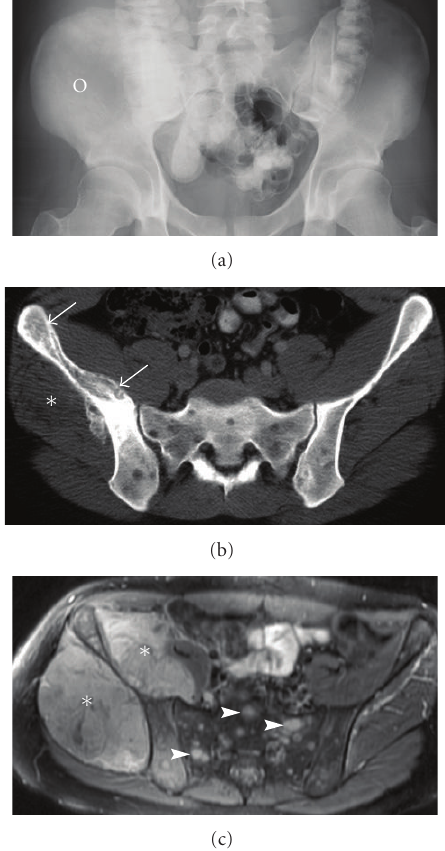
Figure 3: Ewing’s sarcoma. A 21-year-old male with advanced Ewing’s sarcoma. AP radiograph (a) of the pelvis reveals a vague mixed density abnormality di ff usely involving the right ilium (circle). Note the asymmetry when compared to the normal left ilium. Incidental note is made of oral contrast in the bowel. CT scan (b) of the pelvis demonstrates permeative lesion of the right ilium (arrows) and an associated soft tissue mass (asterisk). Small multifocal lytic lesions in the sacrum and bilateral ilium are in keeping with metastasis. Axial T2 image (c) of the pelvis reveals a large exophytic soft tissue mass (asterisk) along the anterior and posterior borders of ilium. Note the predominance of a huge soft tissue mass when compared to the bone abnormality, characteristic of small round blue cell tumors. Marrow edema is noted in the a ff ected right ilium and multiple T2 bright lesions (arrowheads) in the sacrum and right ilium represent